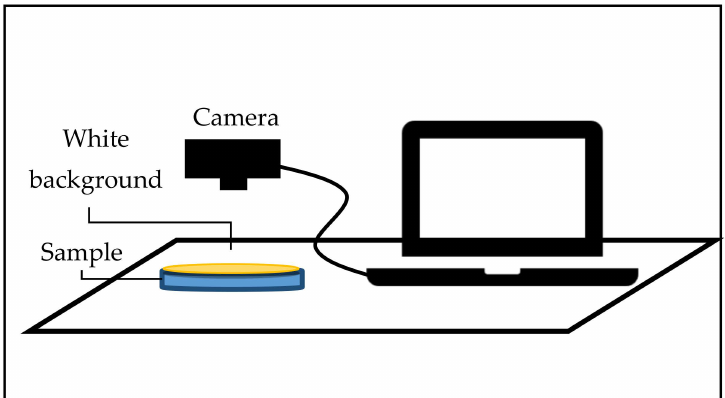
Figure 12. System to capture images of